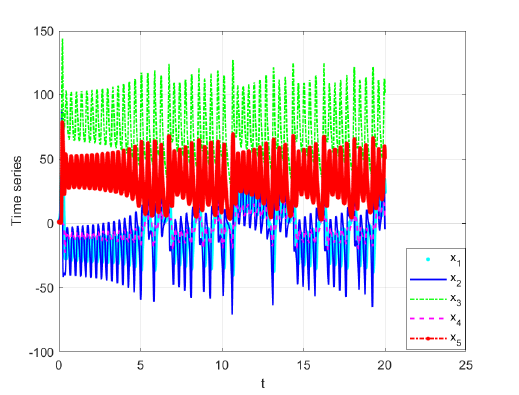
, r = 85, d = 19 , and α = 0.98. 3 3